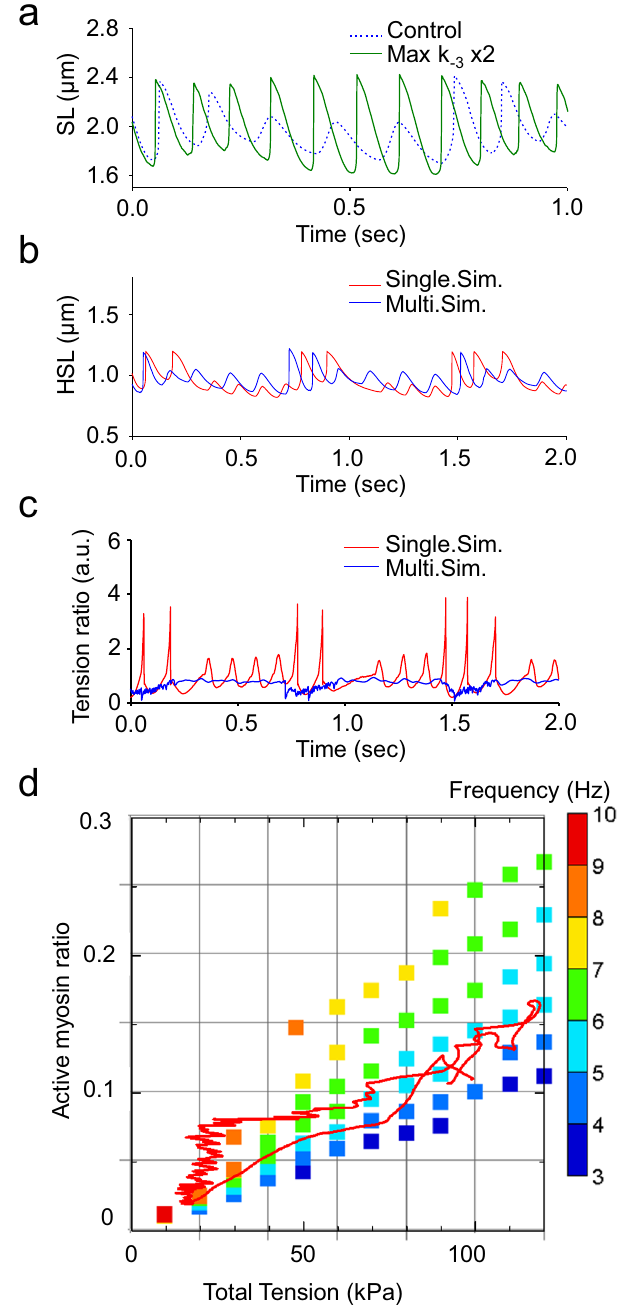
Figure 6. Simulation results for HSOs with different assumptions. (a) Time series of changes in sarcomere length. The changes in sarcomere length that occurred when the upper limit of the k −3 value was changed from 100 to 200 are shown with green lines. The sarcomere length changes that occurred when the upper limit of the value of k 3 was kept at 100 are shown with blue broken lines. ( b) Time series of changes in half-sarcomere length. The results for the single-half-sarcomere model are shown in red, and those for the 40-half-sarcomere model are shown in blue. ( c) Time series of changes in the average tension applied to one myosin molecule forming a crossbridge. The results for the single-half-sarcomere model are shown in red, and those for the 40-half-sarcomere model are shown in blue. ( d) Comparison results for the single-half-sarcomere model under constant external tension and [Ca 2+ ] and the HSO reproduction model (myofibril model with [Ca 2+ ] changes) under a changing external tension and myosin binding ratio. The red line is the trajectory of the HSO reproduction model. ( d ) was created using GraphR (https ://www.graph -proje ct.com/) and Sma4Win (https :// hp.vecto r.co.jp/autho rs/VA002 995/soft/sma4w